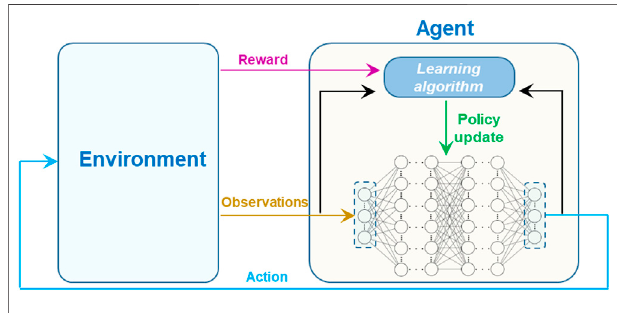
FIGURE 7 | Architecture of a typical